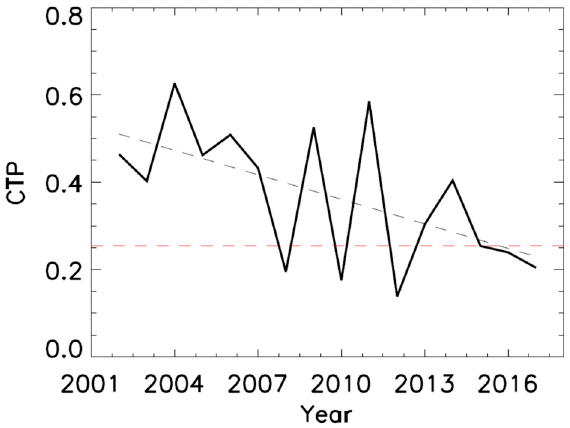
Figure 5. Time series of the correlation coefficient between daily averaged temperature and PM 10 (CTP) during 2001–2017. The black dashed line indicates the regressed trend. The red dashed line is the 95% confidence level.